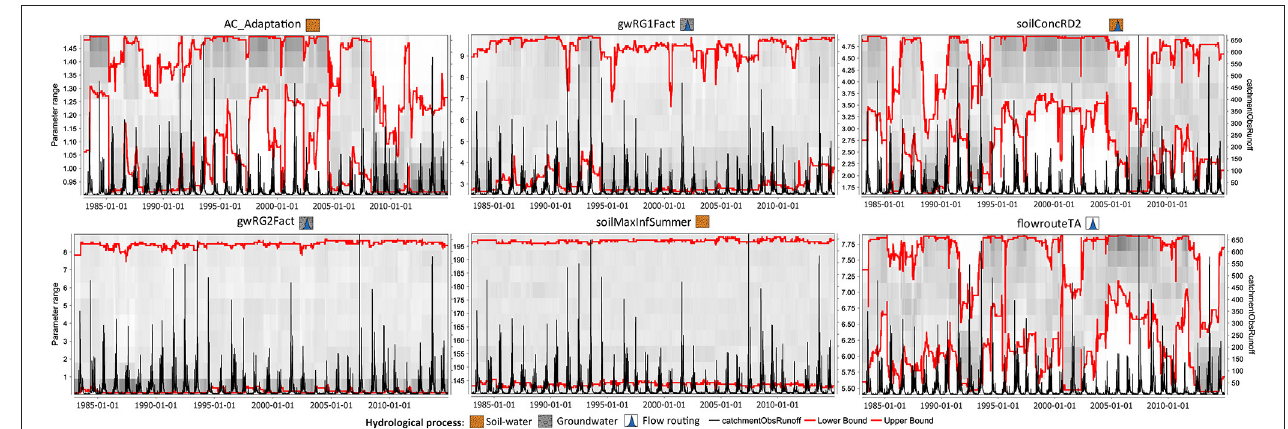
FIGURE 9 | The Dynamic Identifiability Analysis (DYNIA: Wagener et al., 2002) using the Nash–Sutcliffe (NSE; Nash, 1970) efficiency in standard form (E2) for the selected parameters showing the upper and lower parameter bounds of the Monte Carlo Analysis (MCA: red line). The soil-water parameters include scaling of air capacity (AC_Adaption), the Surface runoff delay parameter (SoilConcRD1) and the Maximum infiltration rate during summer parameter (soilMaxInfSummer). Groundwater parameters include Fast groundwater delay (gwRG1Fact), Slow groundwater delay (gwRG2Fact). The routing parameters include the Surface runoff delay parameter (SoilConcRD1), Fast groundwater delay (gwRG1Fact), Slow groundwater delay (gwRG2Fact) and the stream routing parameter (FlowrouteTA). Parameters which have temporal uncertainty show a variability in the upper and lower parameter bounds and where the “best” parameter sets (gray blocks) varies across the simulated time series. These parameters include the AC_Adaption, gwRG1Fact, SoilConcRD1 and FlowrouteTA.